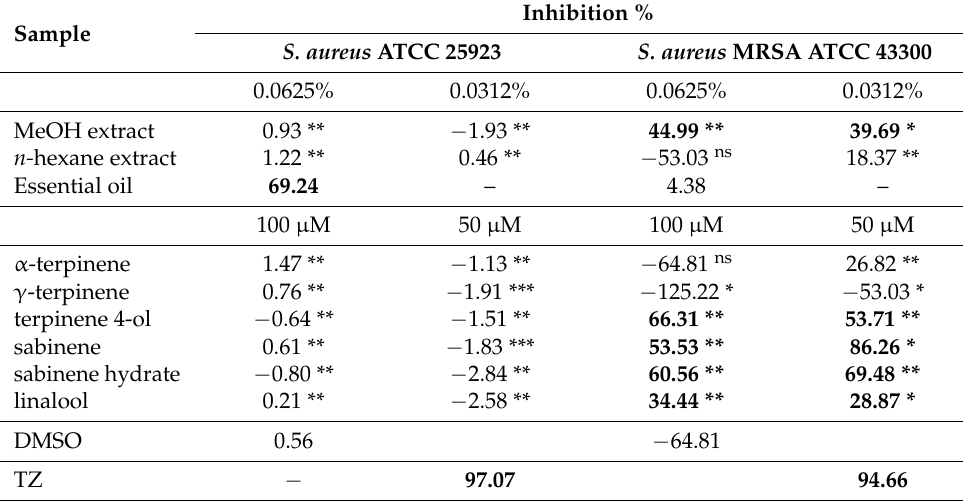
Table 7. Antibiofilm effect of extracts, essential oil of O. majorana and its monoterpene components on sensitive and resistant S. aureus strains 1